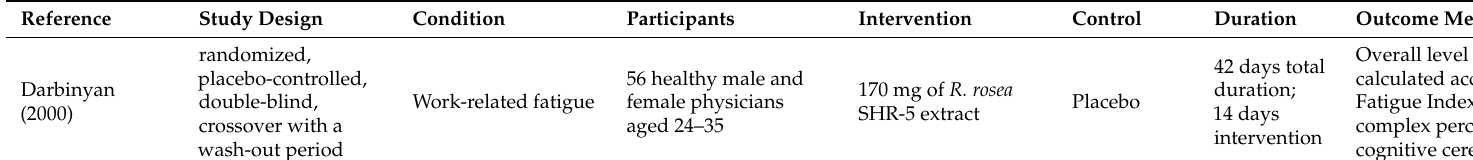
Table 2. Relevant clinical trials on the effects of Rhodiola rosea L on mental and physical